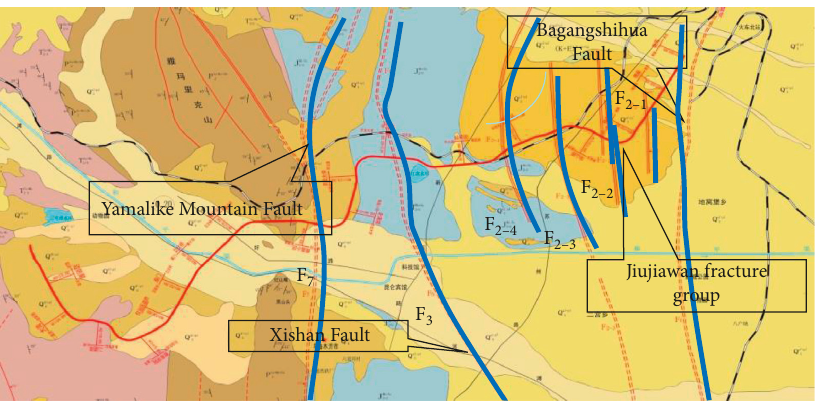
Figure 1: Geotecture of the region of Urumqi Subway Line